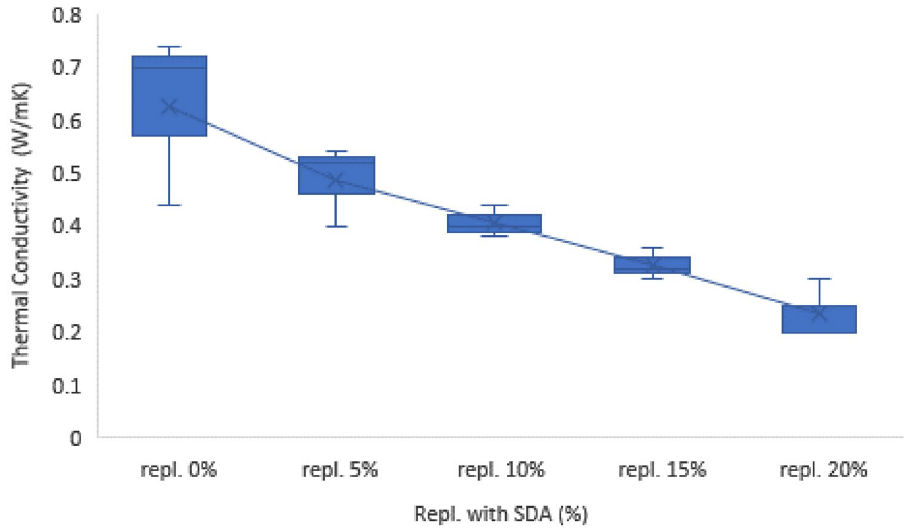
Fig. 9 Thermal conductivity of concrete produced